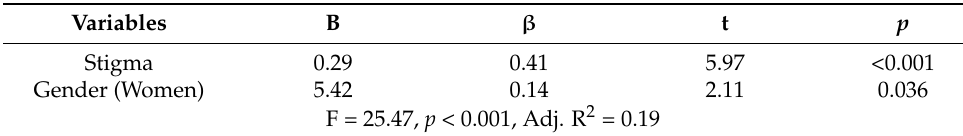
Table 3. Factors influencing depression ( n = 180).